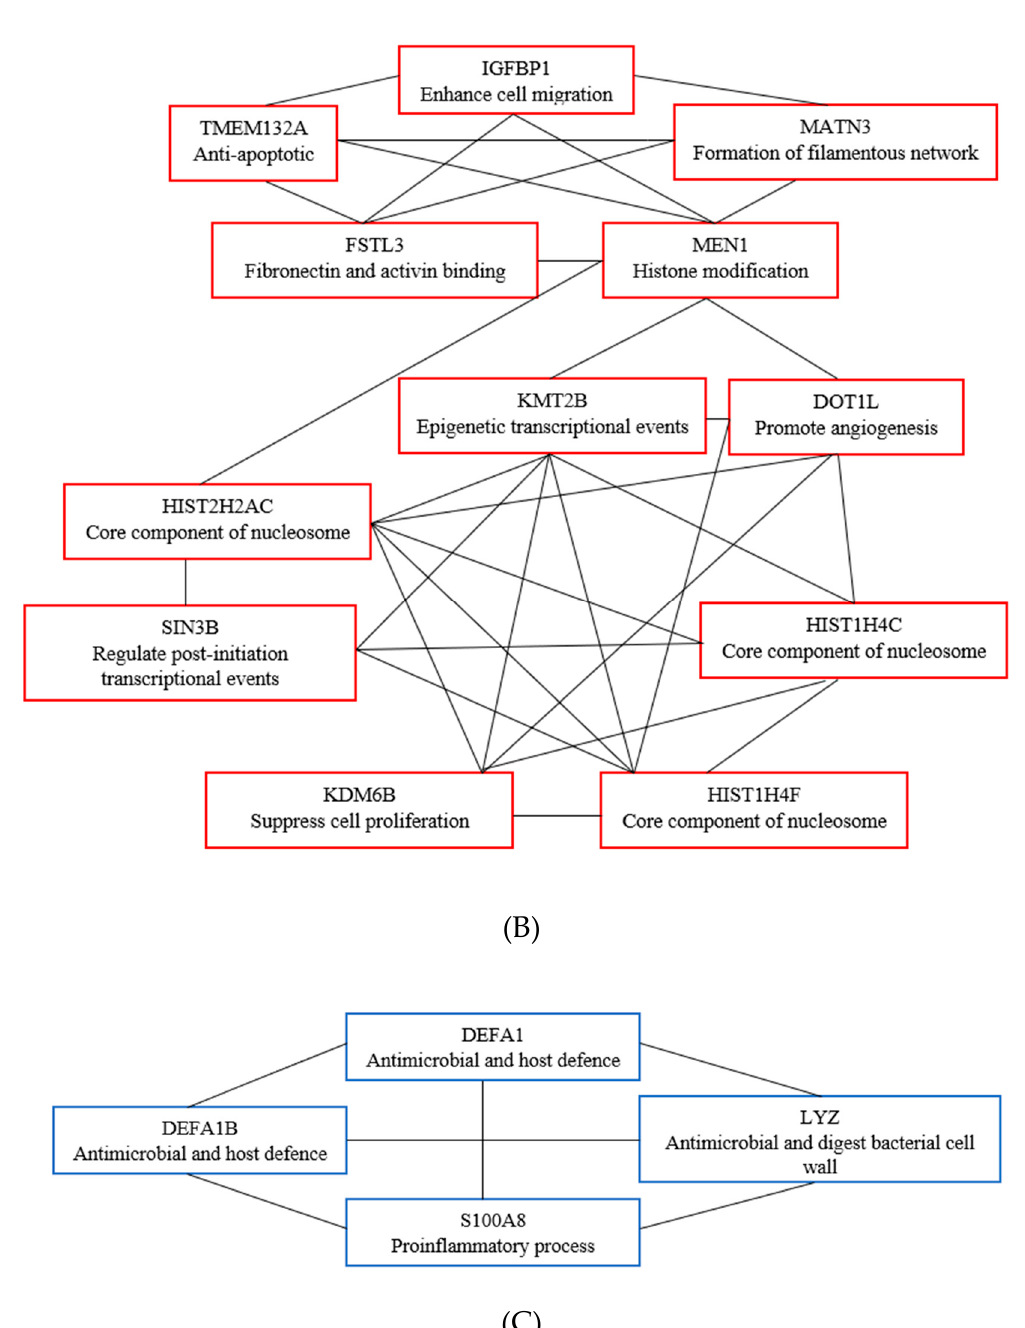
Figure 5. STRING analysis DEGs protein–protein interaction (PPI) network and modular analysis. ( A ) Using STRING online database, total of 250 DEGs (228 upregulated in red standing and 22 downregulated in blue standing) were filtered into the DEGs’ PPI network complex. The two highlighted circle areas are the two most significant clusters identified through MCODE. ( B ) Cluster 1 consists of 12 nodules and 32 edges. ( C ) Cluster 2 consists of 4 nodules and 6 edges. Table 5. Functional annotation clustering on cluster 1.